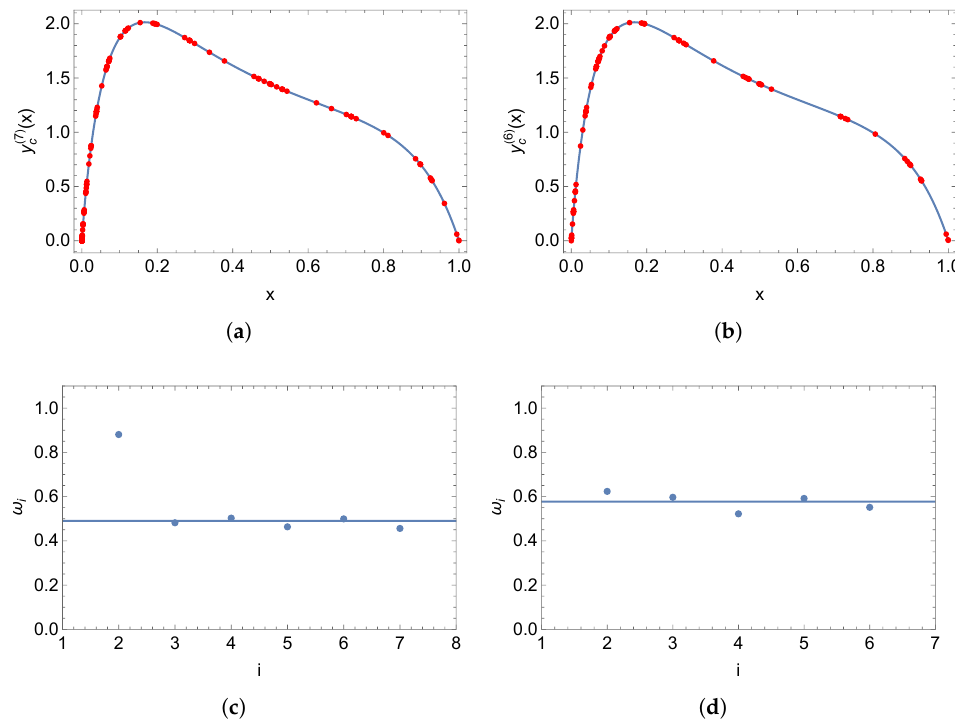
Figure 10. Visualization of the approximating polynomial and the statistic ω i . ( a ) Approximating ( 7 ) ( x ) obtained from multiplying Equation (25) by x . ( b ) Approximating polynomial polynomial y c ( 6 ) ( x ) obtained from y ( x ) − y c ( x ) . ( c ) Plot of ω y c ω i , i = 2,3, . . . ,6. ( ) ω i ≈